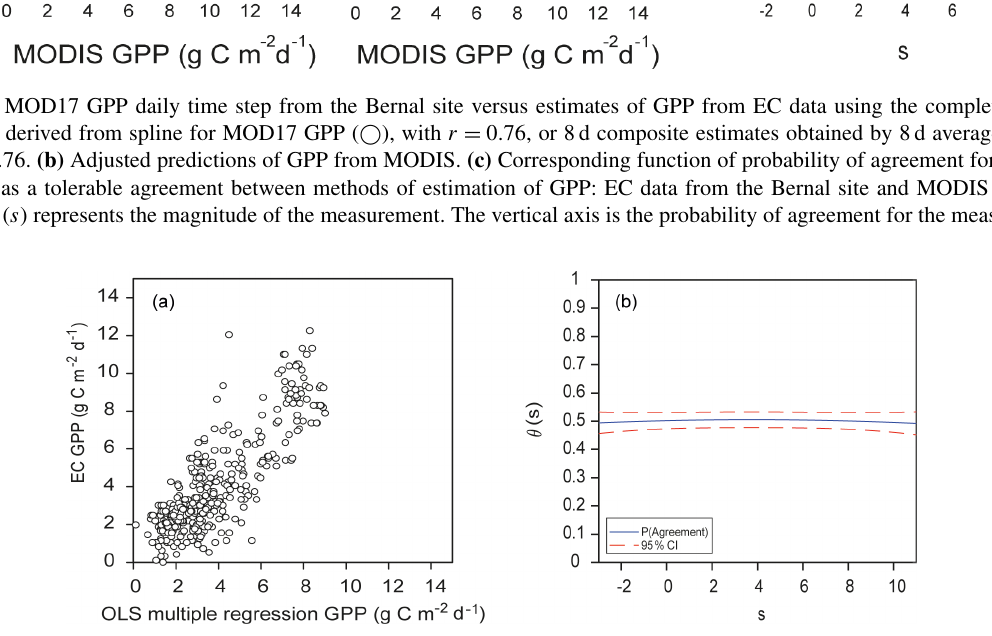
Figure 12. (a) Ordinary-least-squares multiple-regression estimates of GPP for the complete dataset from the Bernal site versus estimates of GPP from EC data, with r = 0 . 82. (b) Respective function of probability of agreement using 1gCm − 2 d − 1 as a tolerable agreement between methods of estimation of GPP: EC data from the Bernal site and OLS multiple regression. The horizontal axis ( s ) represents the magnitude of the measurement. The vertical axis is the probability of agreement for the